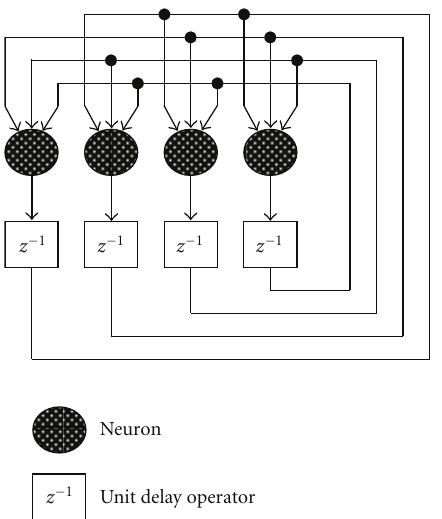
Figure 3: The diagram of a Hopfield neural network with four